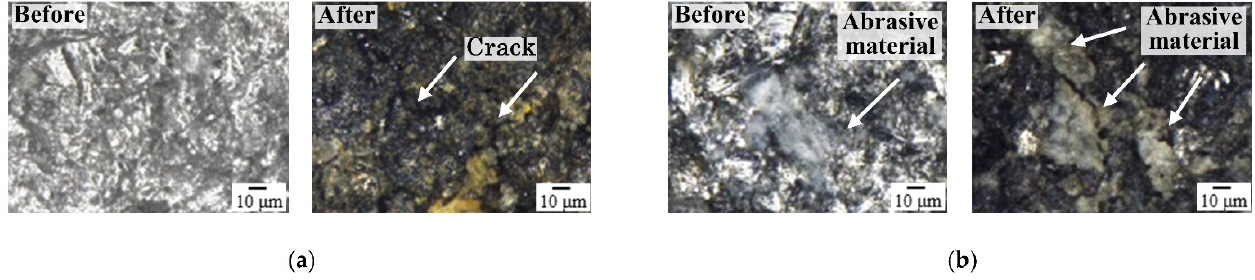
Figure 11. Microscopic images of the surfaces of the blasted specimens before and after immersing in 3.5 wt% NaCl solution: ( a ) MST, ( b ) MAL.